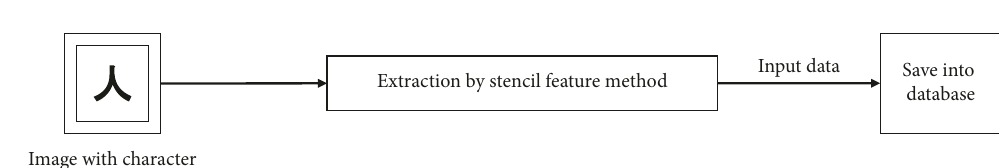
Figure 7: One code with multiple characters.